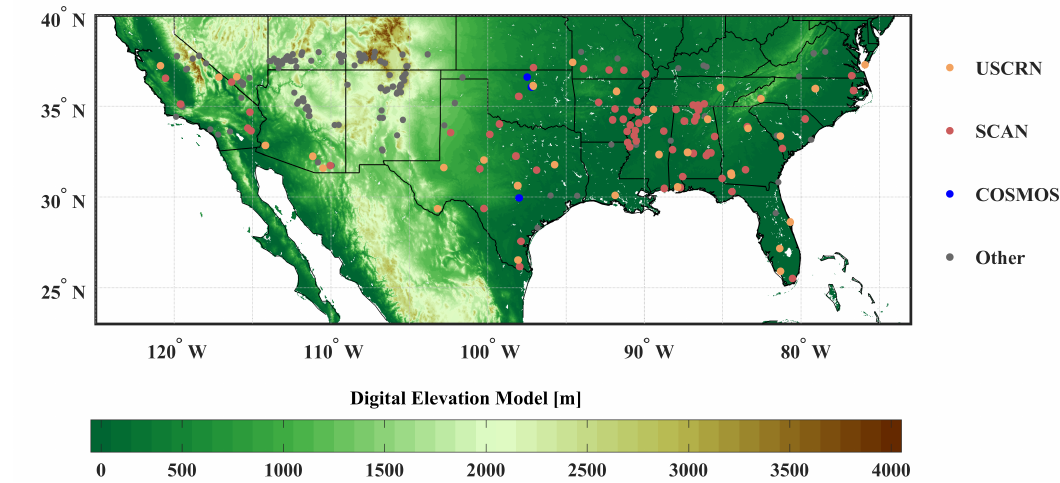
Figure 1. The spatial distribution map of the International Soil Moisture Network (ISMN) sites. Sites shown in gray are excluded based on the masking criteria described in Section